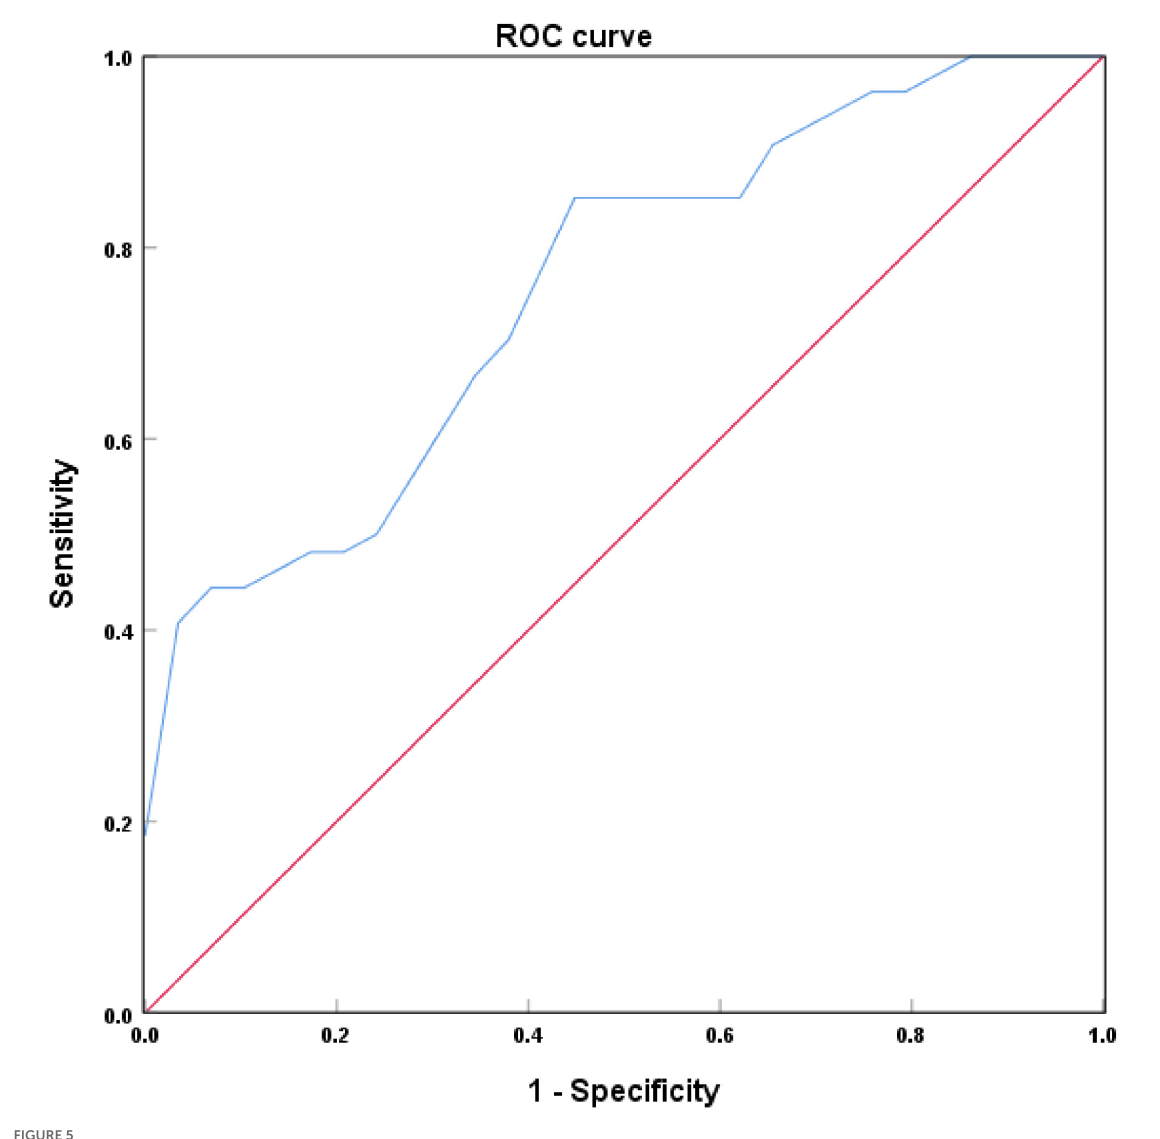
FIGURE5 Receiver operating characteristic (ROC) curve of locus coeruleus (LC) signal contrast ratios in Alzheimer’s disease (AD) and healthy controls